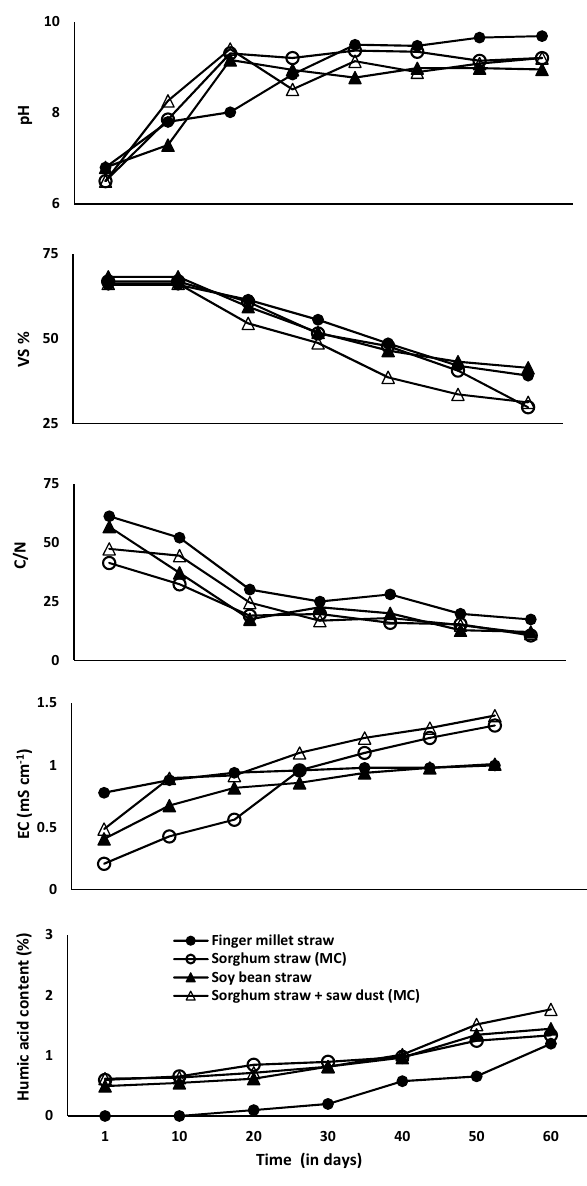
Fig. 3 Decomposition pattern of the straws measured in terms of pH, C/N ratio, volatile solids (VS%), electrical conductivity (EC) and humic acid content (%) in the composting